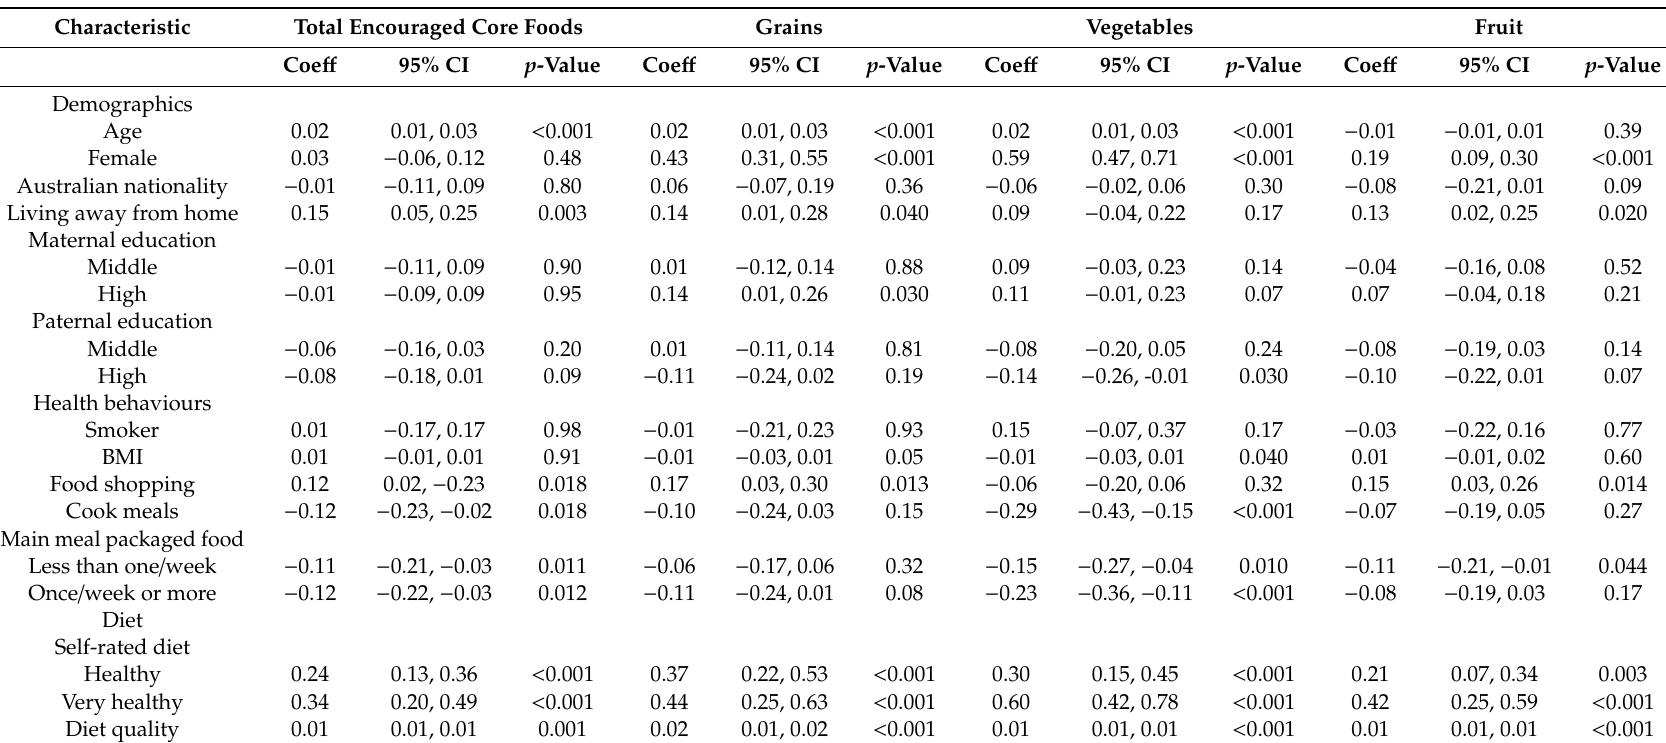
Table 3. Multiple linear regression analysis for the association of liking encouraged core foods with demographics, health behaviours, diet quality and anthropometrics in young Australian adults ( n =